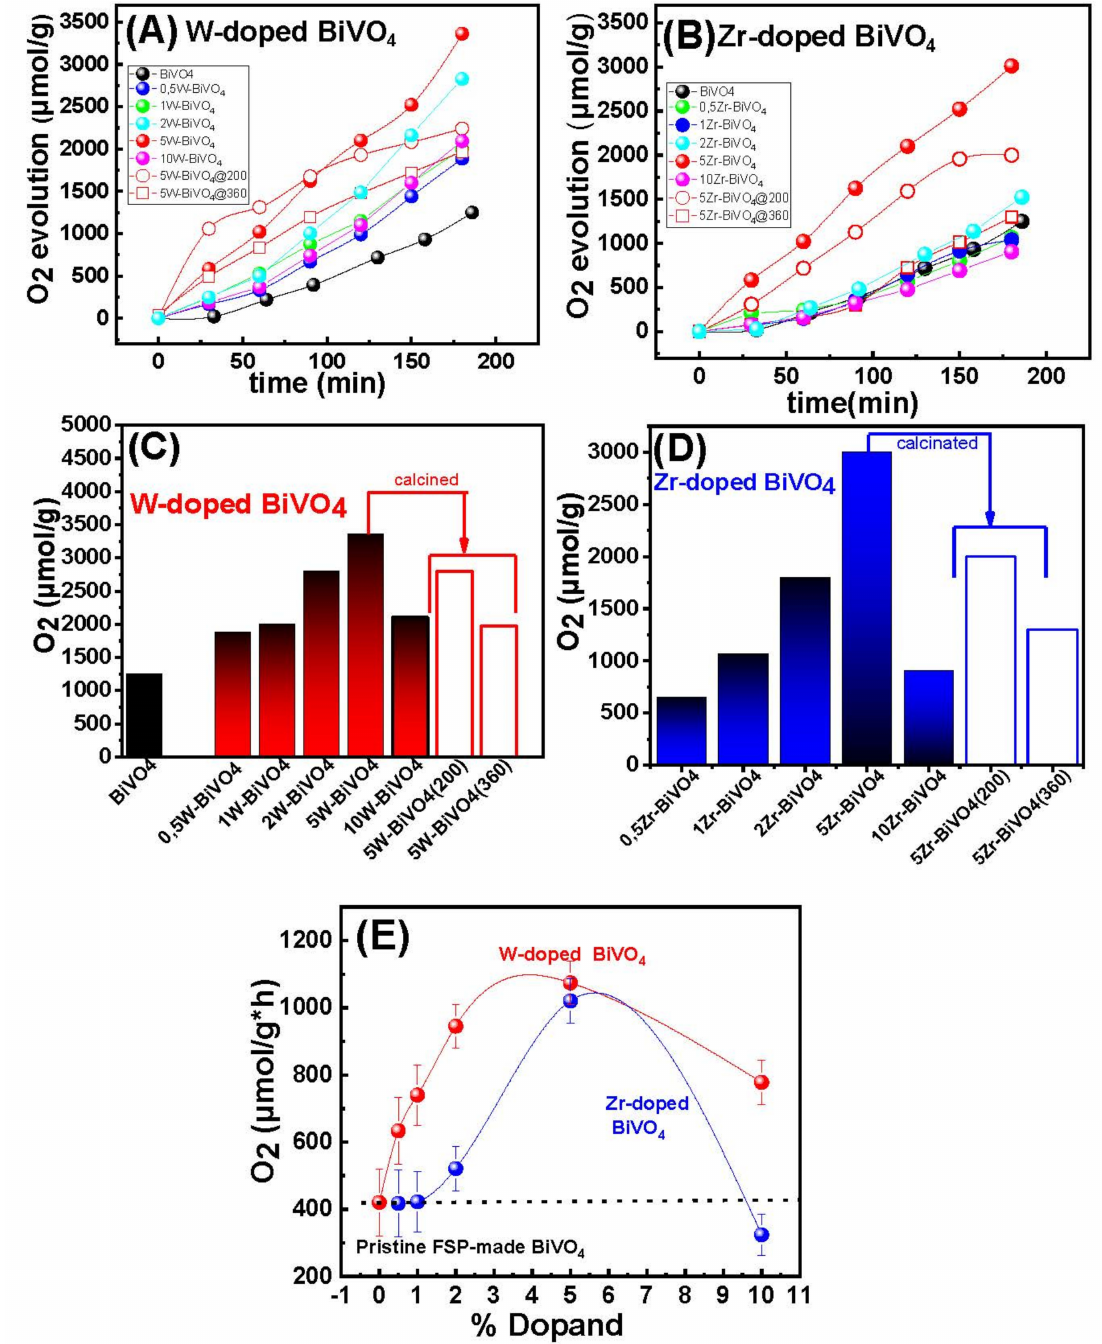
Figure 6. ( A ) Kinetics of O 2 -evolution by the W-BiVO 4 and ( B ) O 2 evolution by Zr-BiVO 4 . Solid symbols are for as prepared materials. Open symbols for calcined at 200 ◦ C (open cycles), or 360 ◦ C (open squares). ( C ) Comparison of O 2 -evolution efficiencies of the present FSP-photocatalysts after 180 min of photocatalytic reaction (W-BiVO 4 ), ( D ) (Zr-BiVO 4 ) and ( E ) O 2 evolution rate vs. the dopant loading. The lines in ( E ) are for guiding the